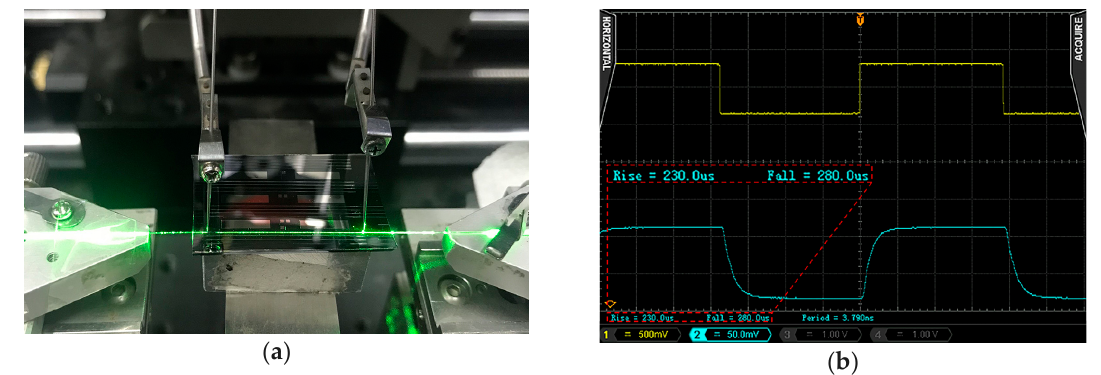
Figure 4. ( a ) The photograph of the device and its test system; and, ( b ) Switching response of the thermal optical switch.